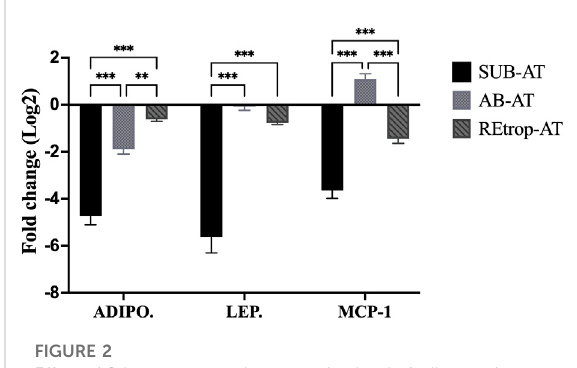
FIGURE 2 Effect of Cd treatment on the expression level of adiponectin (ADIPO.), leptin (LEP.) and monocyte chemoattractant protein 1 (MCP-1)inthreedifferentadiposedepotsofmaleSprague-Dawley rats after 10 weeks Cd treatment. Gene expression results were generated using 2 − ΔΔ Ct method and the mean fold change (log2) values of the targets mRNA expression were normalized to control samples and the endogenous gene. (signi fi cance: more than 2-fold change) and Two-way ANOVA was performed using GraphPad Prism version 9. The signi fi cant difference is represented by ** p < 0.01, *** p < 0.001, ( n =